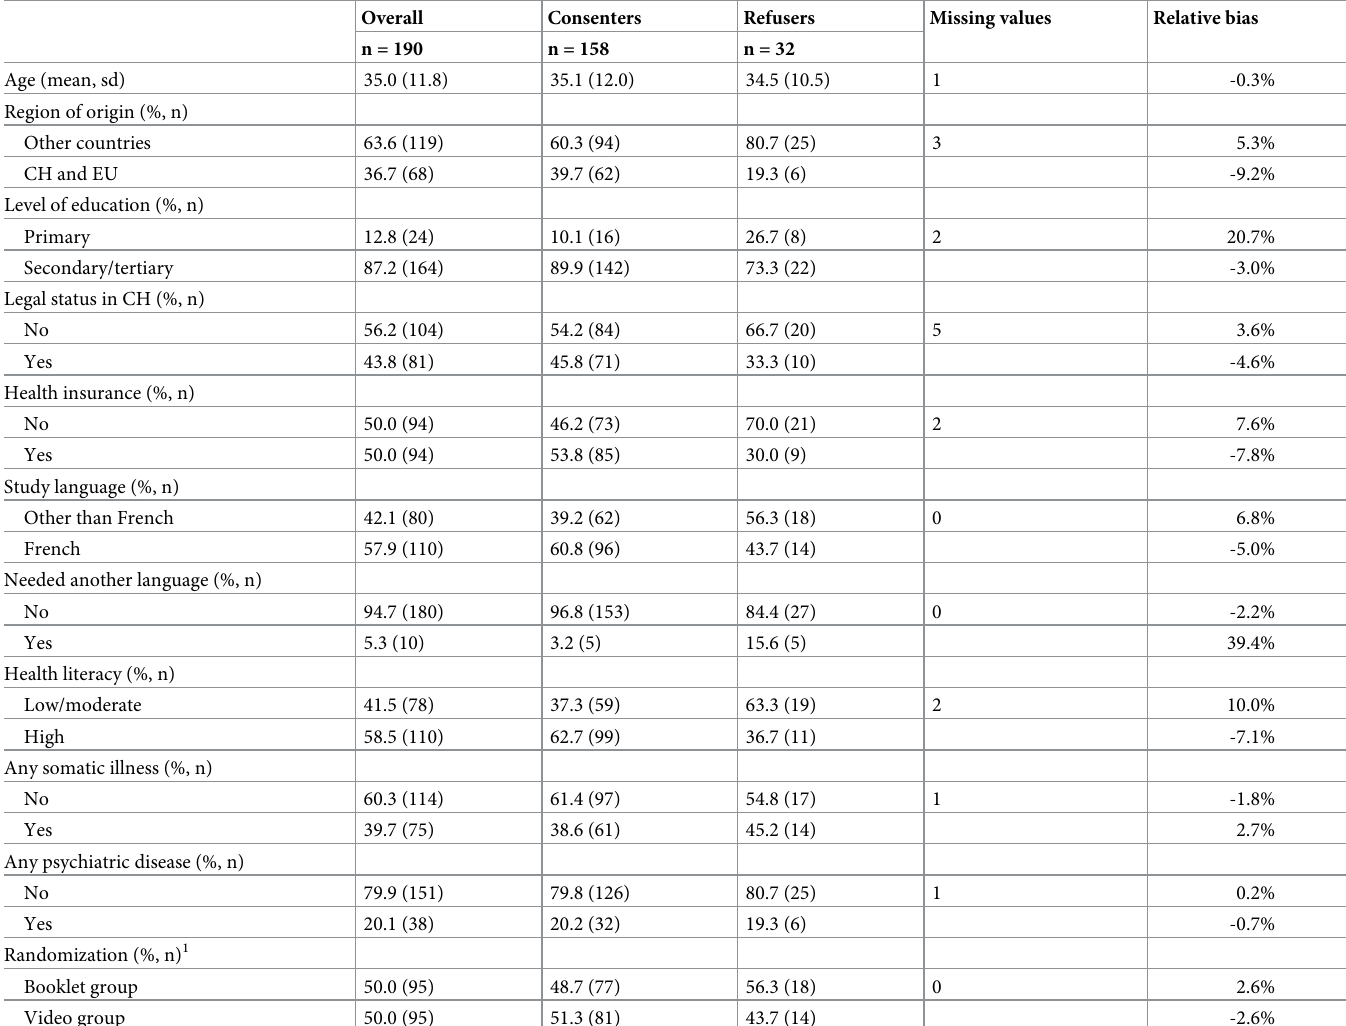
Table 1. Descriptive characteristics of consenters and